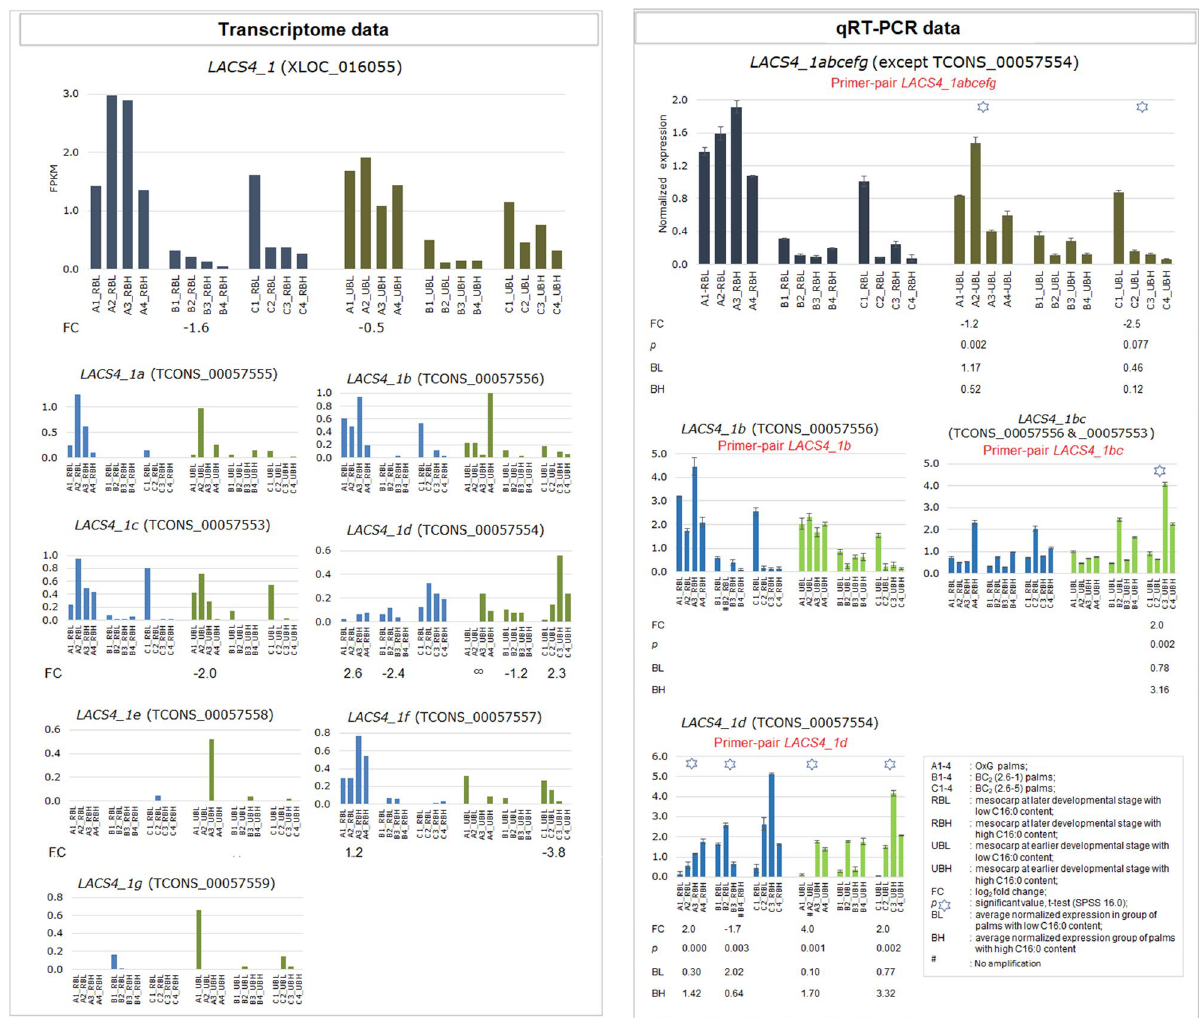
Figure 5. Normalized expression profiles of LACS4_1 (XLOC_016055) and the isoforms (TCONS_) quantified by qRT-PCR (right panel) in comparison with the transcriptomic expression profiles (left panel). The primer for qRT-PCR denoted by two letters ( i.e . _bc) was designed to amplify the common exonic region between isoforms TCONS_00057556